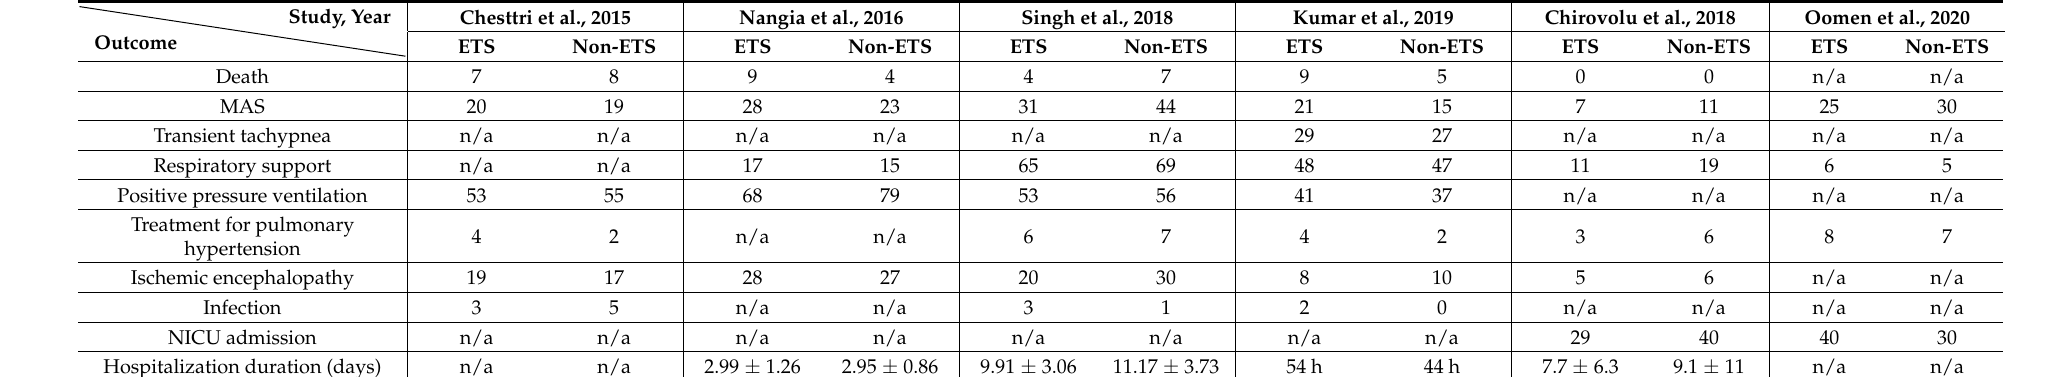
Table 2. Summary of the outcomes of studies (in ascending chronological order) between the ETS and non-ETS